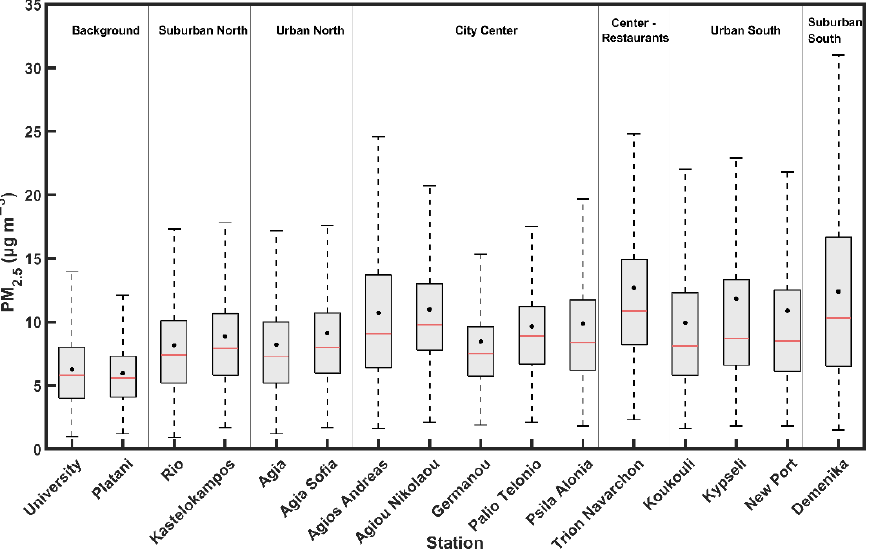
Figure 3. Boxplots of daily average PM 2 . 5 concentrations at all stations of the network. The black dots and the solid red lines correspond to the mean and median PM 2 . 5 concentrations. The bottom and top edges of the box indicate the 25th and 75th percentiles. One of the highest average concentrations was in an area of the city center with a Table 2. Average ( ± standard deviation) concentrations and the range of daily PM 2.5 measurements high restaurant density. This is consistent with the modeling predictions of Siouti et al. (in µ g m − 3 ) of each station during the full (02/2017–12/2019), cold, and warm [27]. A site in the southern part of the city (Kypseli) was also a PM 2 . 5 hot spot with rela- tively high PM 2 . 5 average levels. This is due mainly to high concentrations in these areas during the winter (Table 2). The lowest average concentrations were recorded, as expected, in the two back-